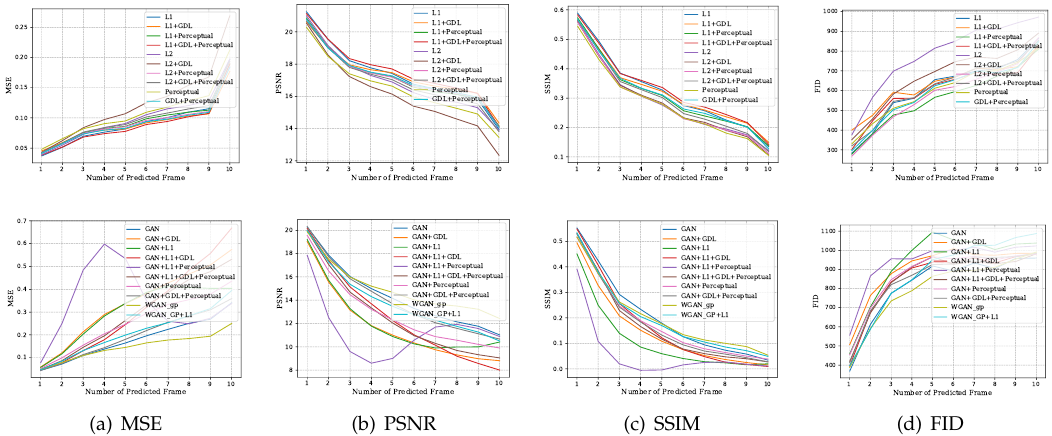
Figure A4. Mean values per predicted frame for the KIT AIS Vehicles dataset. (MSE and FID: smaller values are better, PSNR and SSIM: larger values are better).